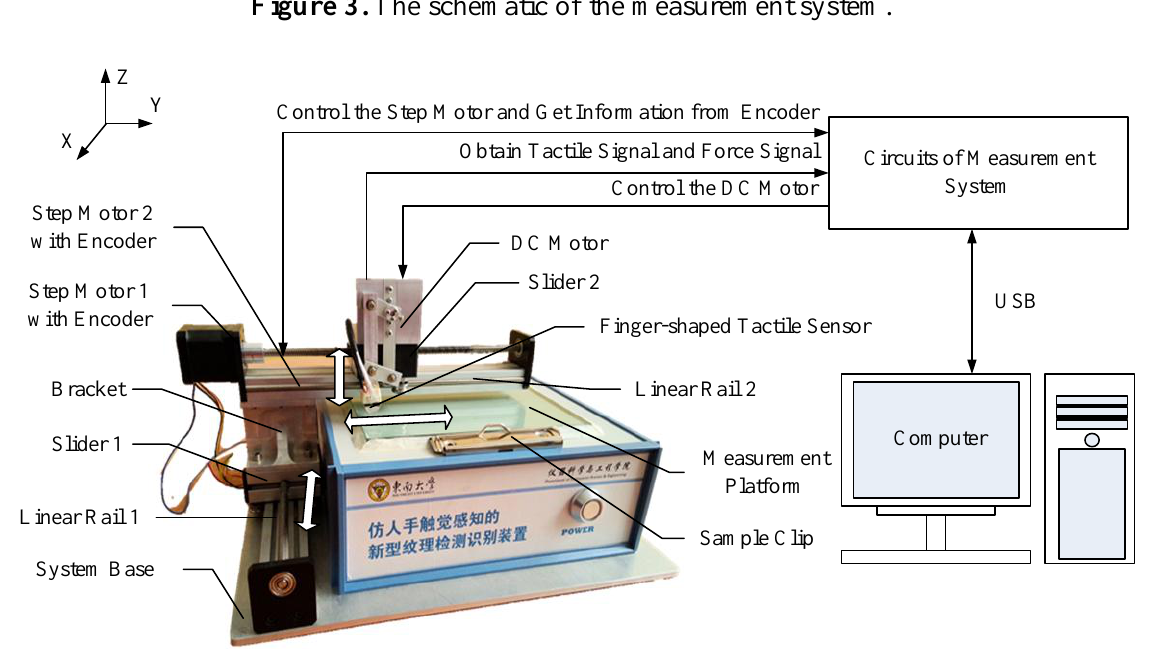
Figure 3. The schematic of the measurement